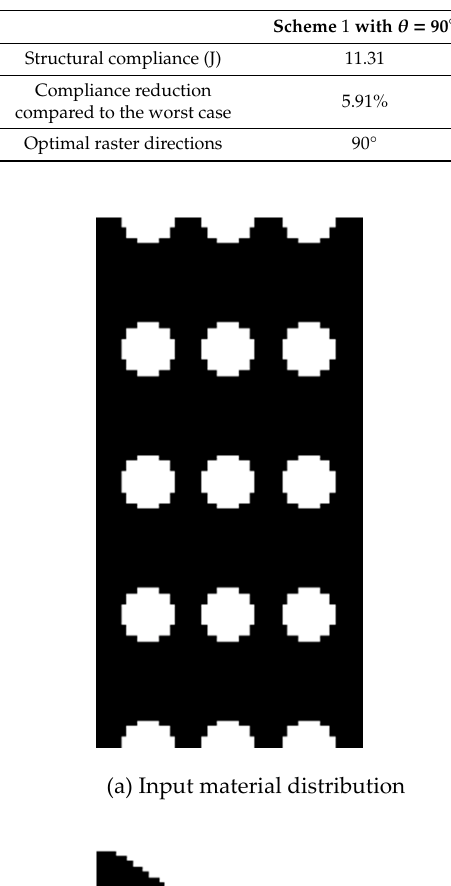
Table 2. Data of The Cantilever Optimization